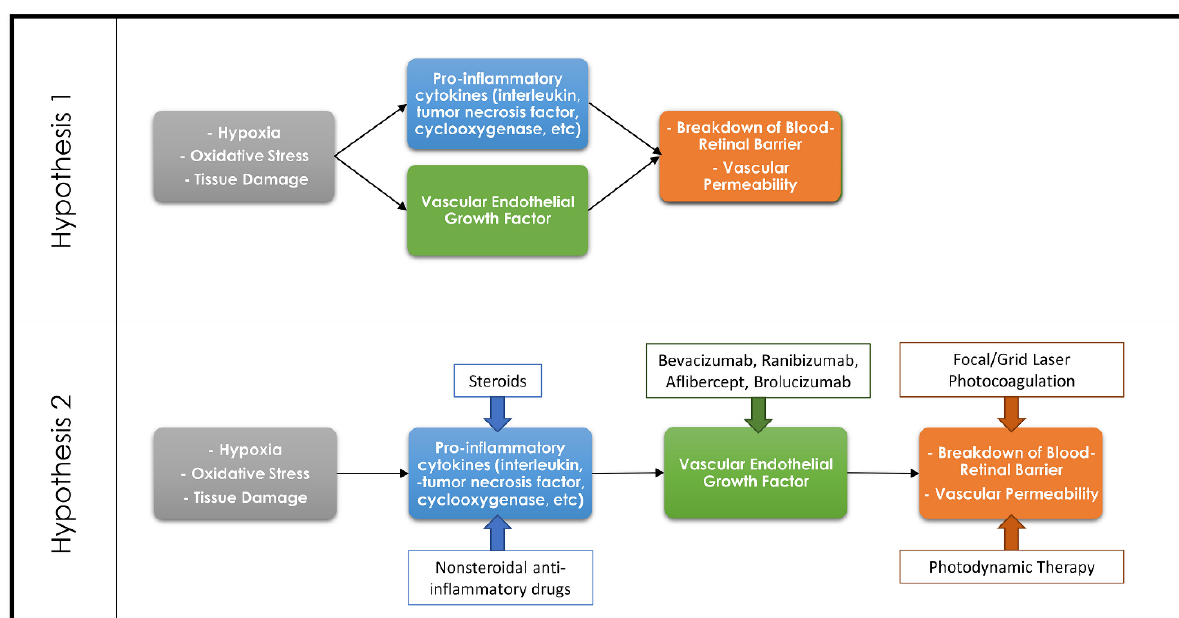
Figure 1. Diagram demonstrating the countering theories regarding the association of the inflammatory cascade and VEGF in the development of retinal pathologies. Hypothesis 1 theorizes that the inflammatory cascade and VEGF are both separate pathways resulting in a breakdown of the blood–retinal barrier, whereas Hypothesis 2 theorizes that the inflammatory cascade results in upregulation of VEGF which in turn leads to the breakdown of the blood–retinal barrier. Common therapeutic options and their targets within these pathways are demonstrated on the Hypothesis 2 diagram.